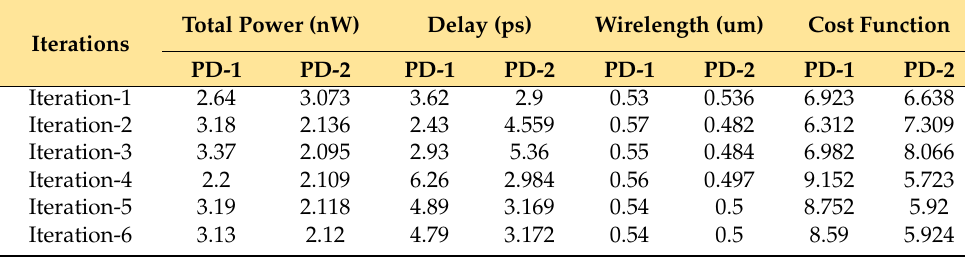
Table 3. Iterative optimization in AES_CORE